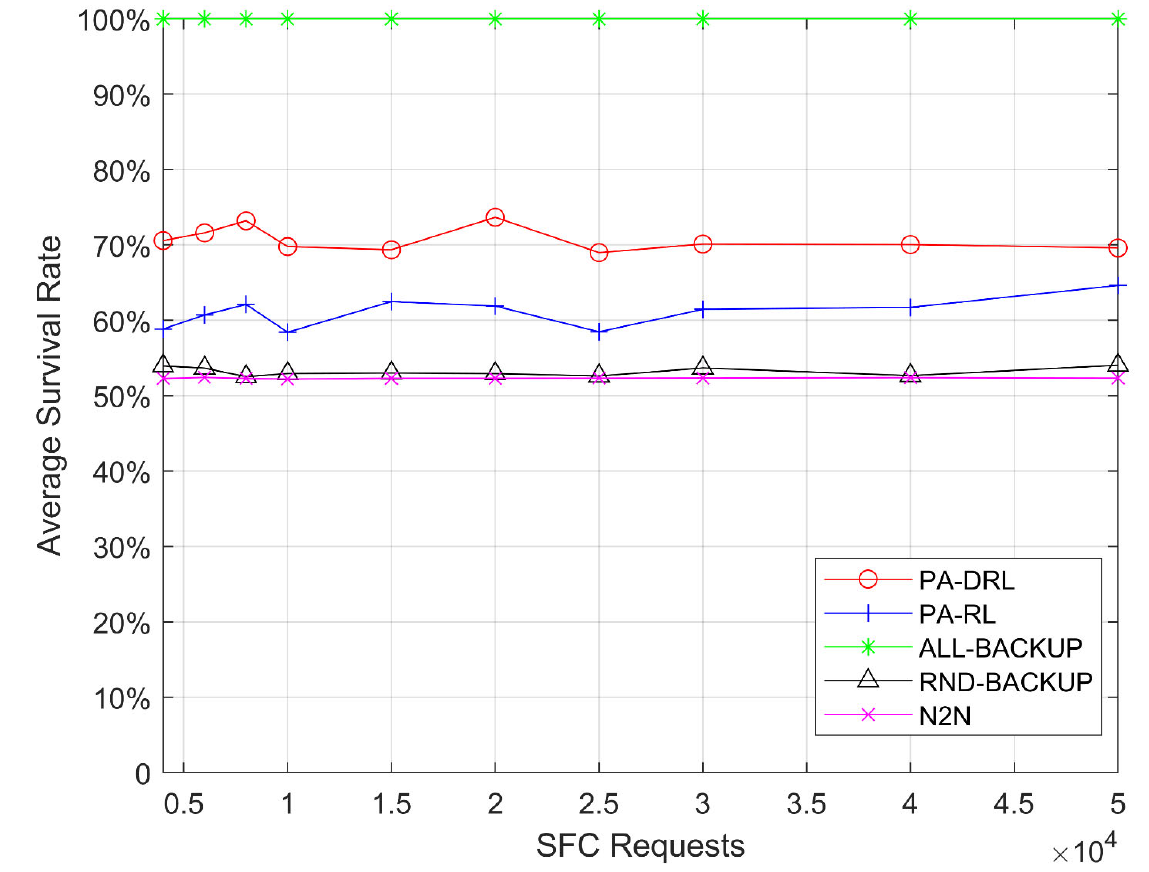
Figure 4. Average survival rate after failure of any node under each SFC requests number.